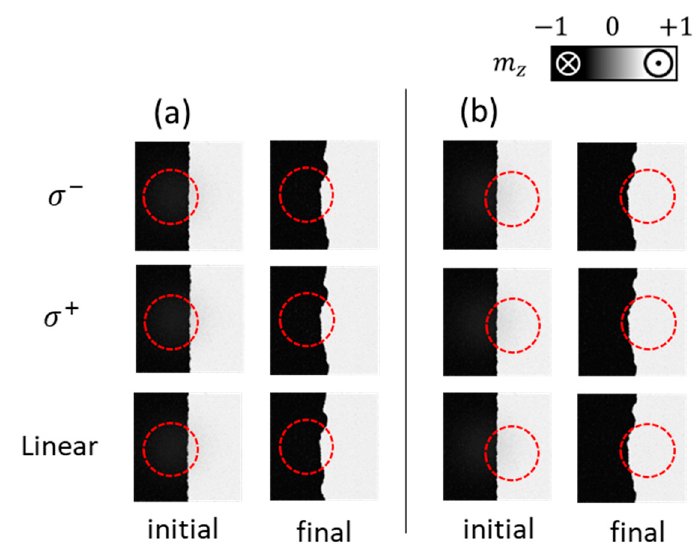
Figure 8. Initial and final snapshots of the magnetization of a sample with down and up domains separated by a domain wall. The final magnetic state is obtained after 100 laser pulses of τ L = 200 ps. A MCD absorption rate of 10% is considered for both circular polarizations (top ( σ − ) and bottom ( σ + ) graphs). The case of linear polarization (MCD = 0) is depicted in bottom graphs. Red dotted circles indicate the location of the laser beam. The in-plane sample size is 1.5 µ m × 1.5 µ m and the center of laser spot is displaced 192 nm to the left ( a ) or to the right ( b ) of the DW.